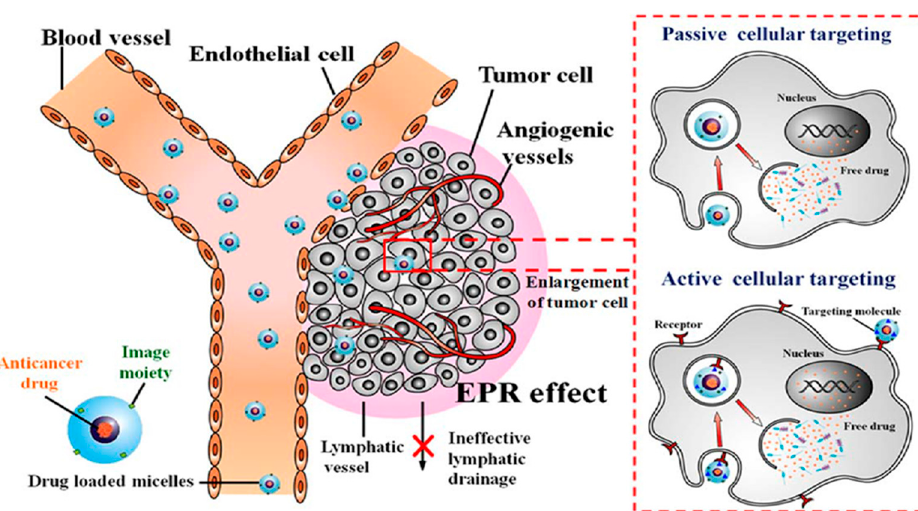
Figure 6. Schematic representation of drug loaded micelles (spheres) with imaging agents, from the administration site to the tumour tissue. After administration, micelles (10–200 nm) display specific targeting of tumour growth via passive targeting with cellular endocytotic uptake from exterior fluid to the cancer cells. Active targeting through receptor-mediated internalization is achieved by attachment of antibody ligand molecules, to the surface of micelles (Adapted with permission from Chen et al. [81]).